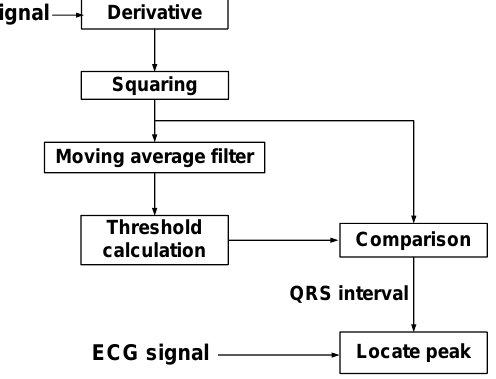
Figure 27. Measured waveforms of the ECG and IMP channels.